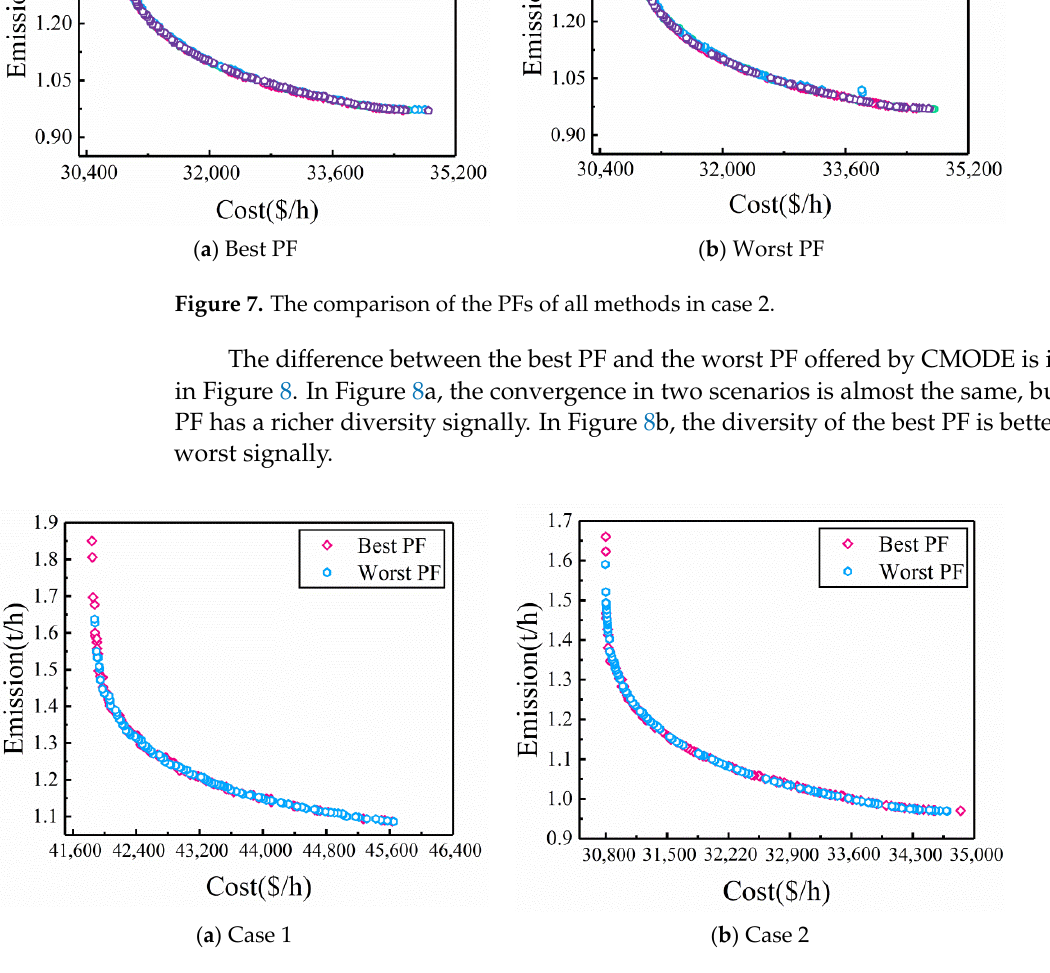
Figure 8. The comparison of the best and the worst PFs of CMODE.